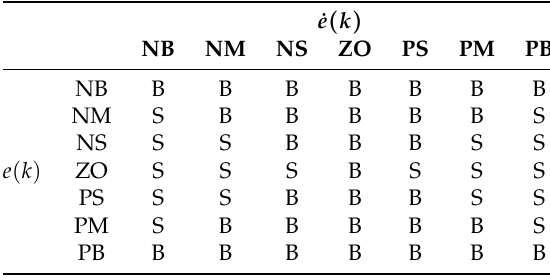
Table 2. Fuzzy rules for Kp (cid:48) [13].